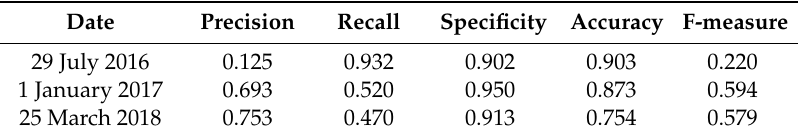
Table 9. Precision, recall, specificity, accuracy, and F-measure based on the confusion matrix for three image dates by the whole OSM dataset.